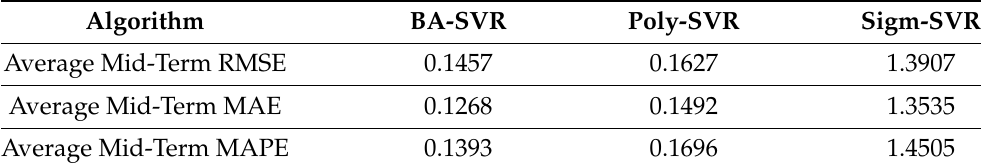
Table 10. Comparison of mid-term forecast